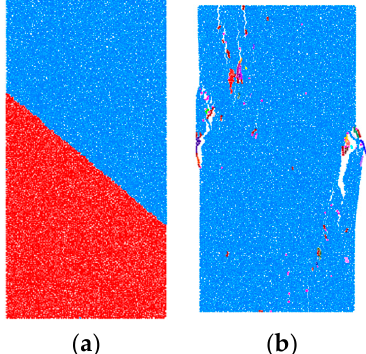
Figure 8. Post-peak failure images with different joint elastic property with joint orientation β = 30°.